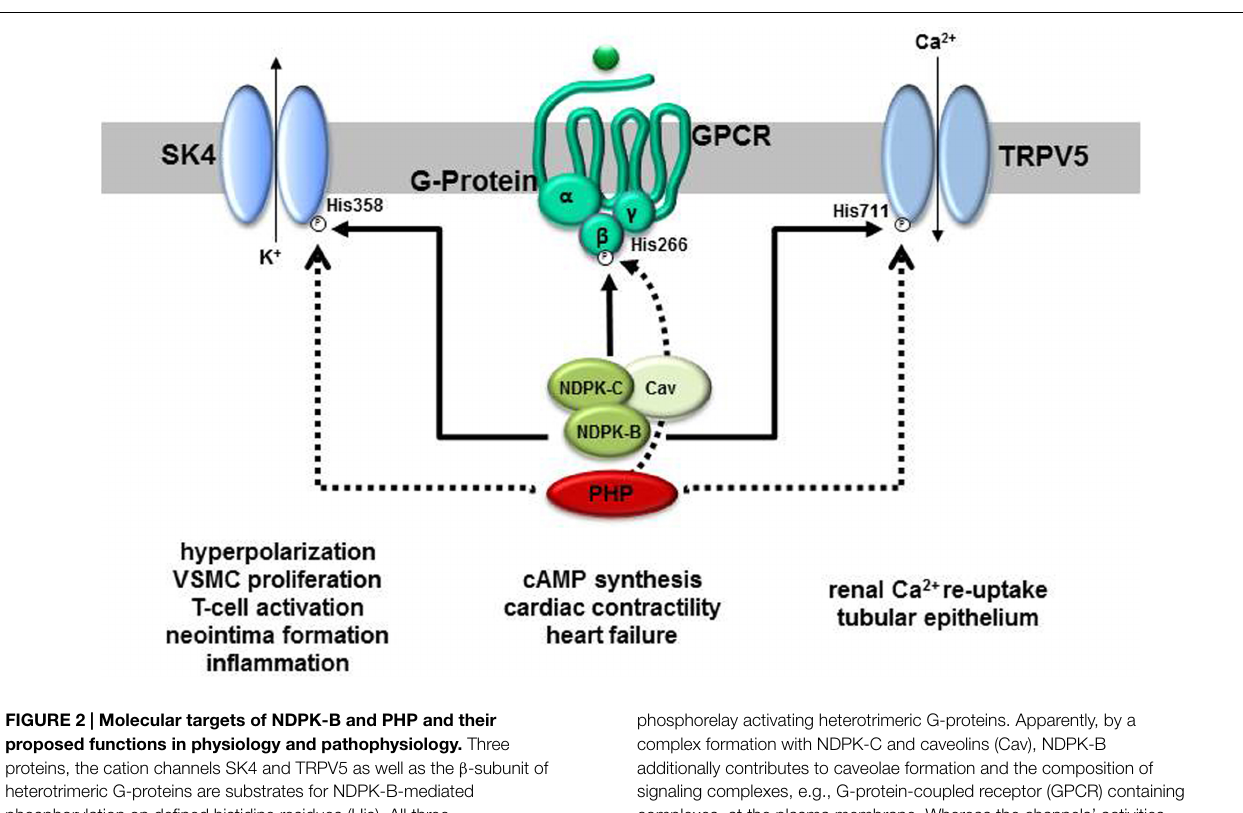
FIGURE 2 | Molecular targets of NDPK-B and PHP and their proposed functions in physiology and pathophysiology. Three proteins, the cation channels SK4 and TRPV5 as well as the b -subunit of heterotrimeric G-proteins are substrates for NDPK-B-mediated phosphorylation on defined histidine residues (His). All three phosphohistidines are also substrates to dephosphorylation by PHP. Whereas the phosphorylation of classically regulates the open-probability of the channels, the phosphorylated G-protein b -subunit takes part in a